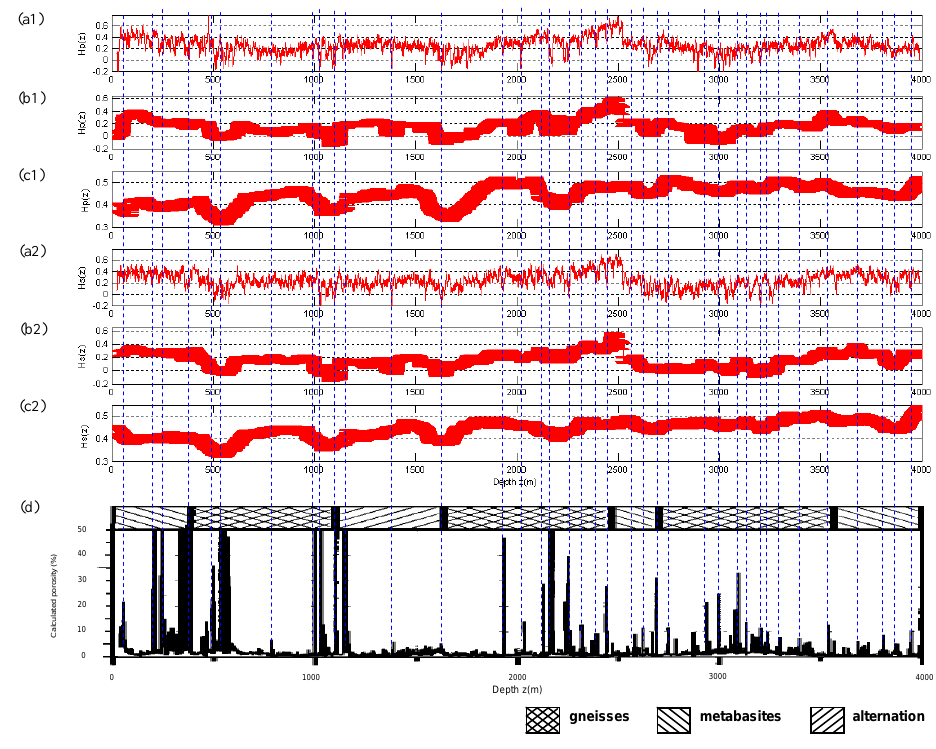
Fig. 5. A comparison between the Hurst functions obtained from sonic logs recorded at the pilot borehole (VB) and the estimated porosity log. (a1) , (b1) , and (c1) correspond to P-wave velocity log, while (a2) , (b2) , and (c2) are related to S-wave velocity log. Local changes of the Hurst parameter H(z) obtained by: LWA: (a1) and (a2); ALWA: (b1) and (b2); and PA: (c1) and (c2); (b1), (b2), (c1) and (c2) are presented with statistical error bars. (d) A porosity estimation modified from Pechnig et al.